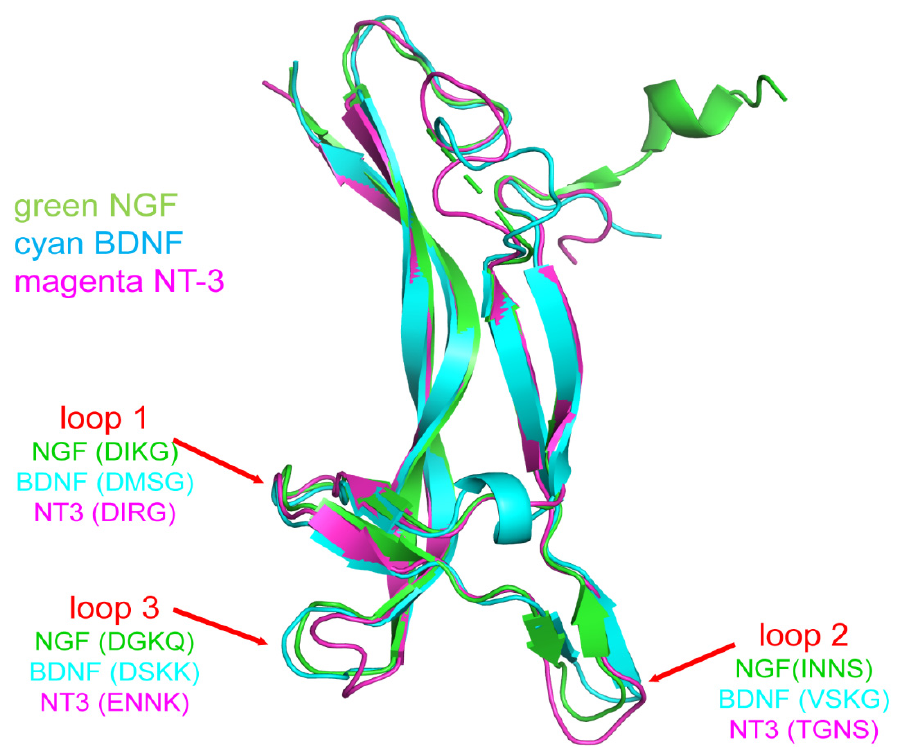
Figure 1. Structures of NGF, brain-derived neurotrophic factor (BDNF), and neurotrophin-3 (NT-3) from crystallography. Abbreviations inside parenthesis are the standard one letter code denotations for amino acids in the loops.